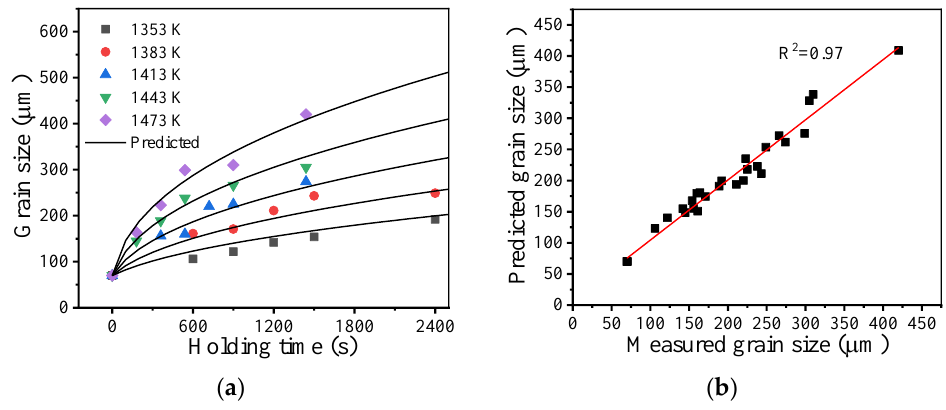
Figure 6. Comparisons between measured and predicted grain sizes: ( a ) fitting lines; ( b ) the coeffi- cient of determination.